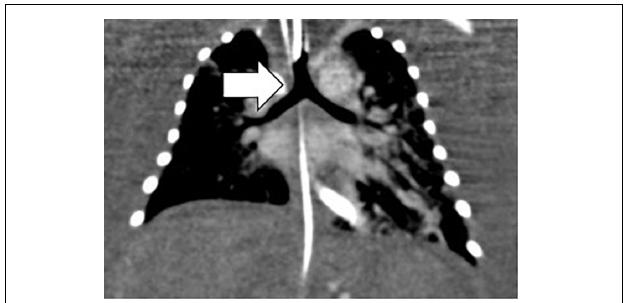
FIGURE 4 | Bronchial tree anatomy and the sub-type of isomerism by neonatal thoracic CT. Arrow white, left isomerism of tracheal bifurcation with bi-lobar lungs.